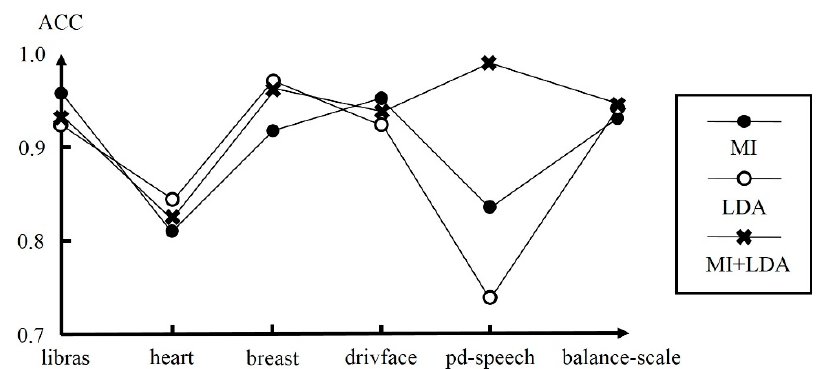
Figure 6. Performance of SL-Scheme with mutual information (MI), linear discriminant analysis (LDA), and MI+LDA.